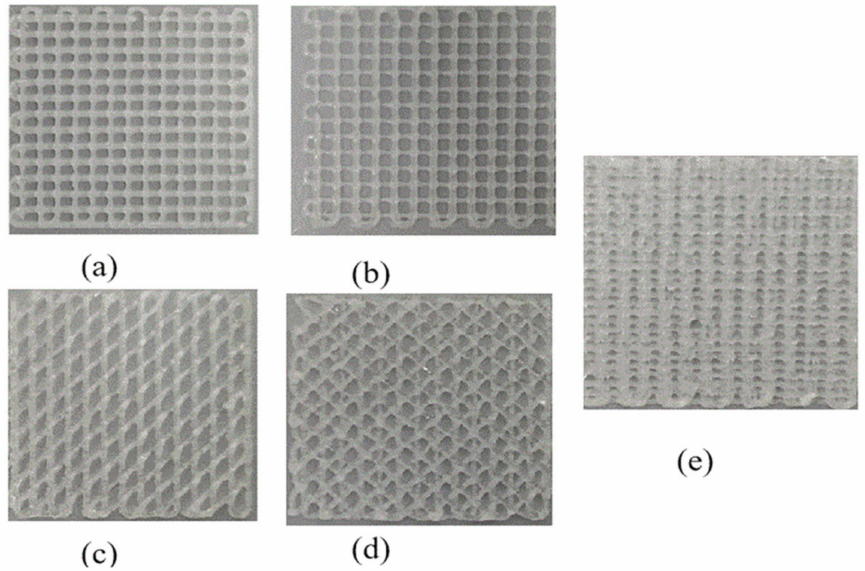
Figure 14. The printing results with di ff erent internal structure patterns. ( a ) printed result with 0 / 90 degree sca ff olds with 1 mm spacing; ( b ) printed result with 0 / 90 degree sca ff olds with 1.2 mm spacing; ( c ) printed result with 0 / 45 degree sca ff olds with 1.2 mm spacing; ( d ) printed result with 0 / 45 / 135 degree sca ff olds with 1.2 mm spacing; ( e ) printed result with staggered sca ff olds with 1.2 mm